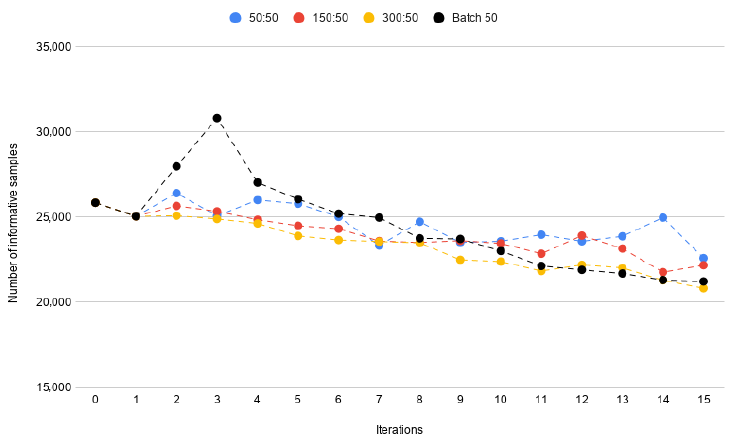
Figure 10. The number of informative samples in the pool for networks trained with only part of the samples used in previous